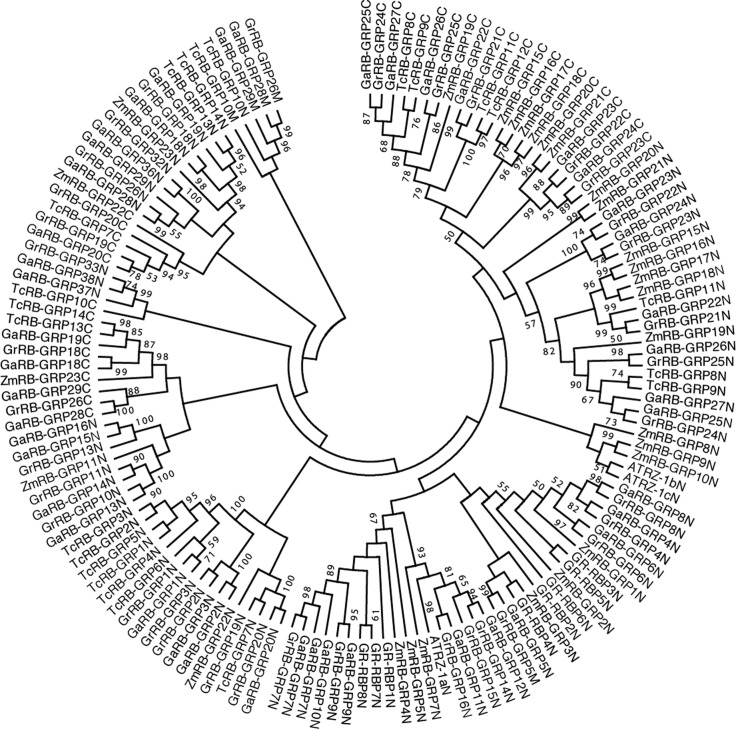
Phylogenetic relationships of RB-GRP genes from G.arboreum, G.raimondii, Arabidopsis thaliana, Theobroma cacao and Zea mays.The unrooted phylogentic tree was constructed using MEGA 4.0 by Neighbor-Joining method and the bootstrap test was performed with 1000 replicates. Percentage bootstrap scores of > 50% were displayed.